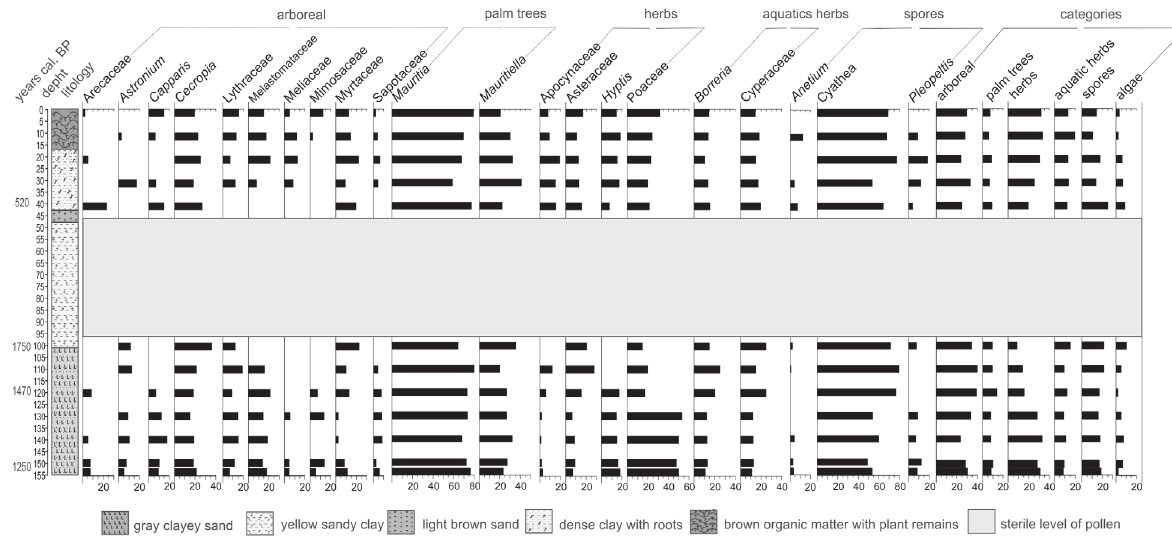
Figure 5 - Percentage pollen diagram of the Bom Jesus sediment